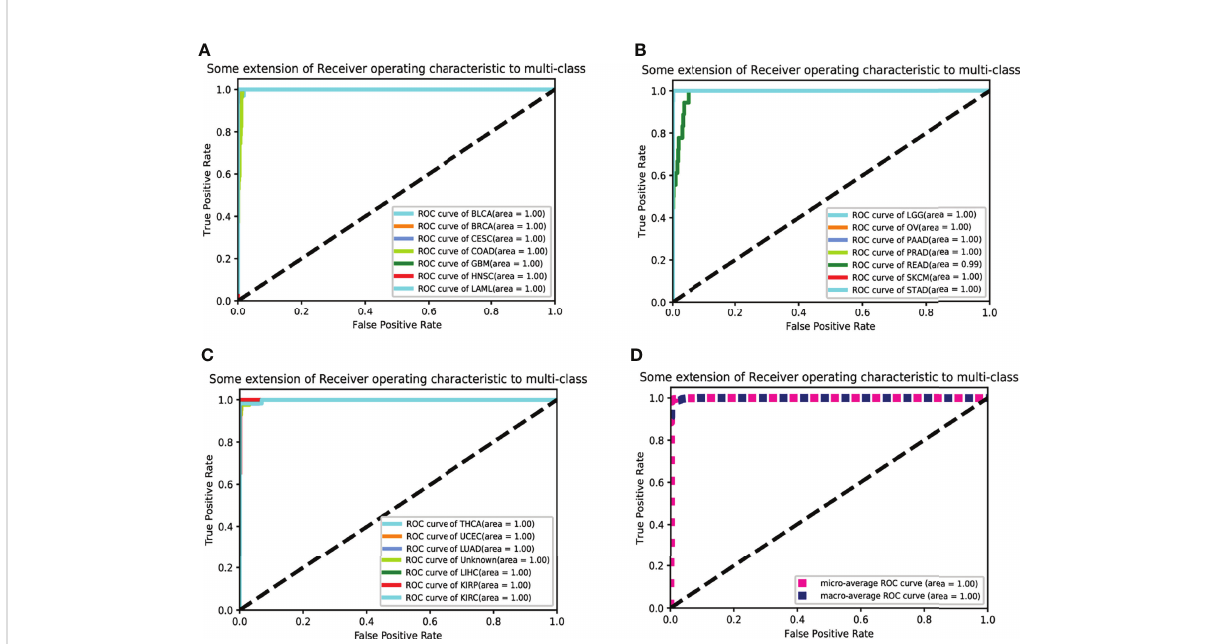
FIGURE 3 The receiver operating characteristic curve (ROC curve) for classi fi cation. Twenty cancer ROC curves of the optimal 10-fold CVs ’ results are shown in (A – C) . (D) The average ROC curve.